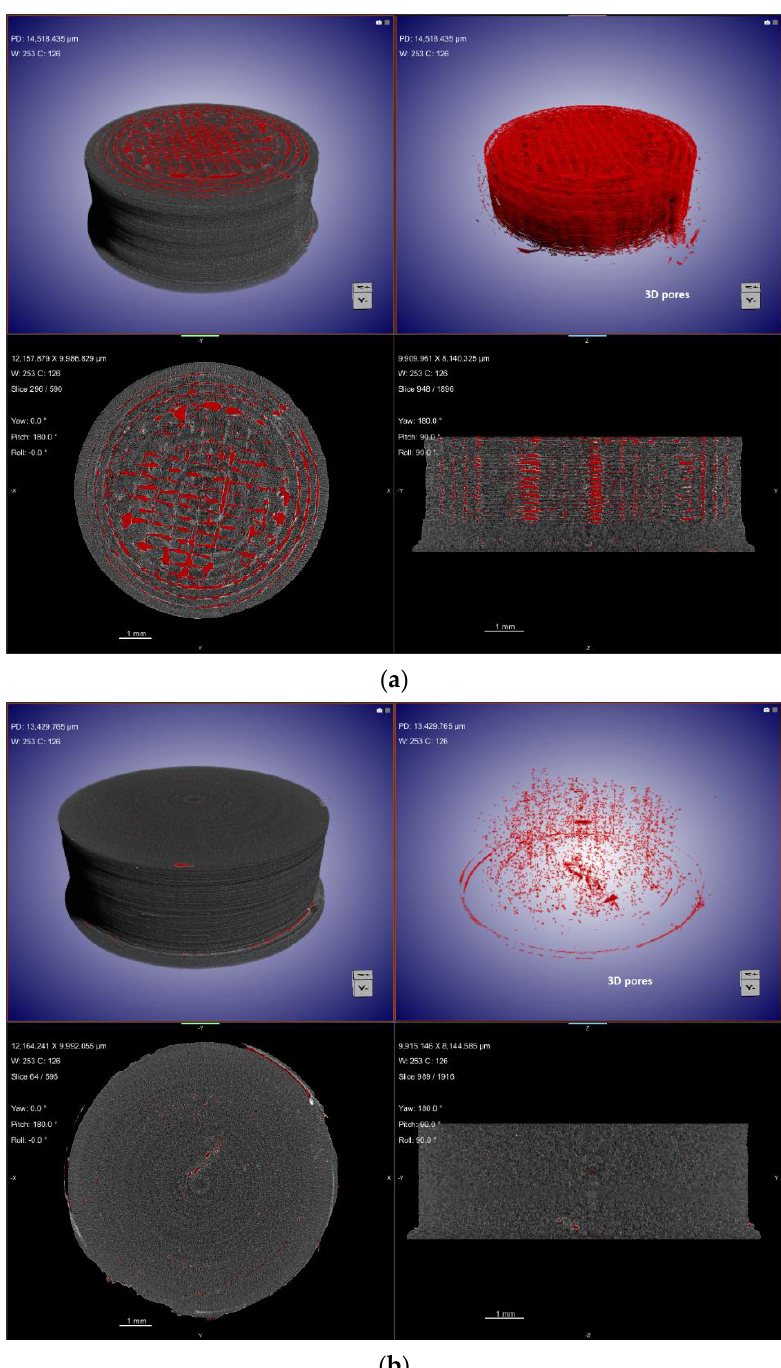
Figure 3. XµCT images showing material deposition and 3D pore distribution (red) in 3D-printed tablets containing ( a ) 20% NAP and ( b ) 30% NAP.